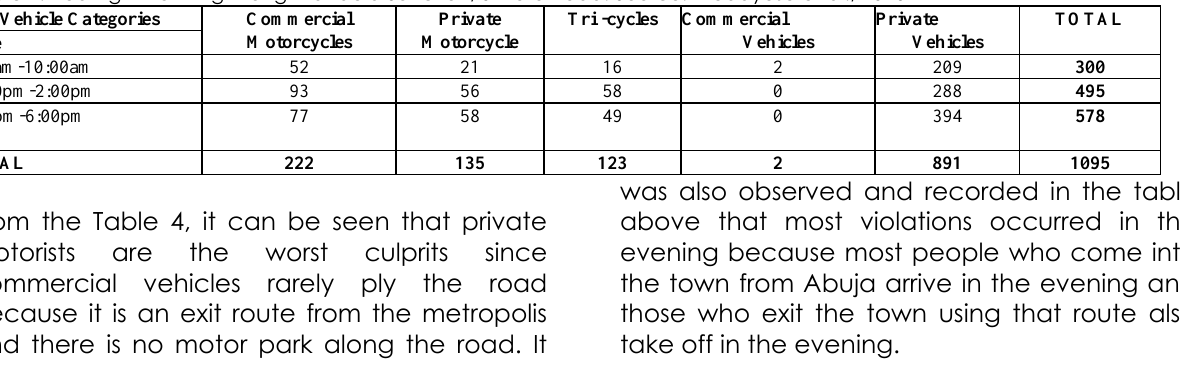
Table 5. Red Light Running along Government House road, Minna. Source: Medayese et al., 2016 Vehicle Categories